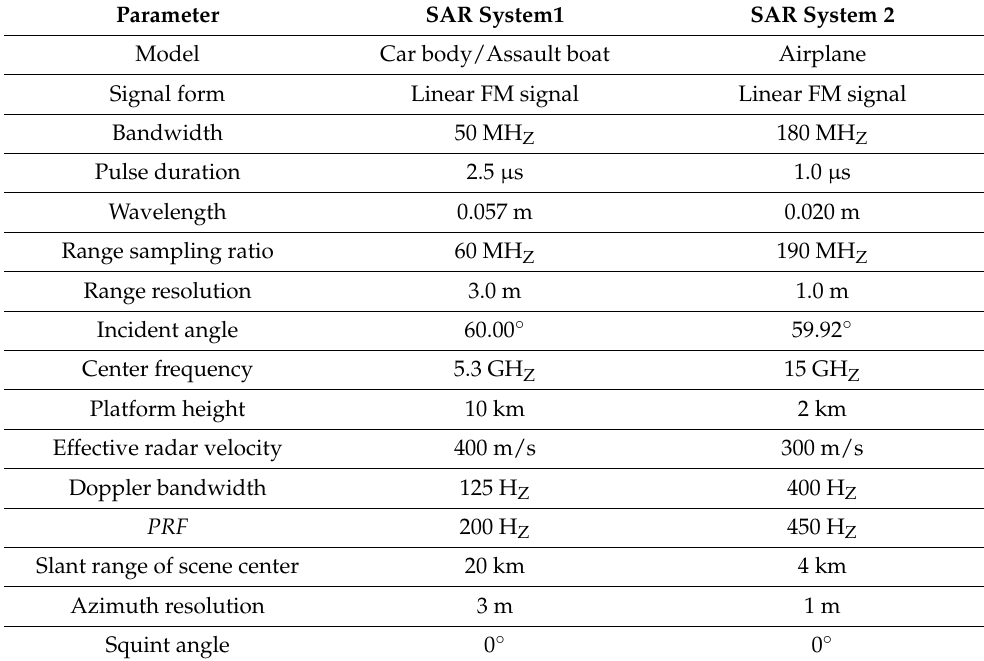
Table 1. Airborne SAR System Parameters.